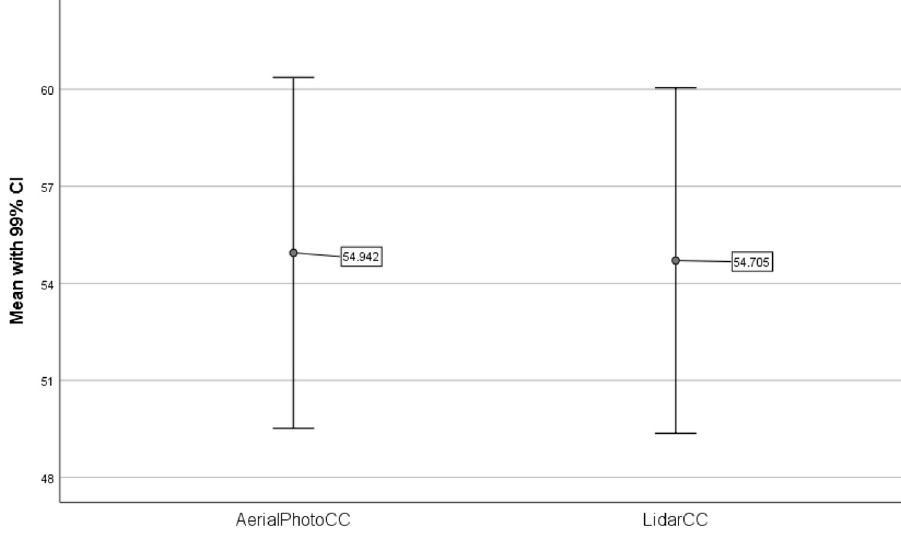
Fig 2. Comparison of the means with 99% confidence interval between 2015 canopy cover using the USGS tree cover mapping tool and methods (AerialPhotoCC) and LiDAR analysis (LidarCC).